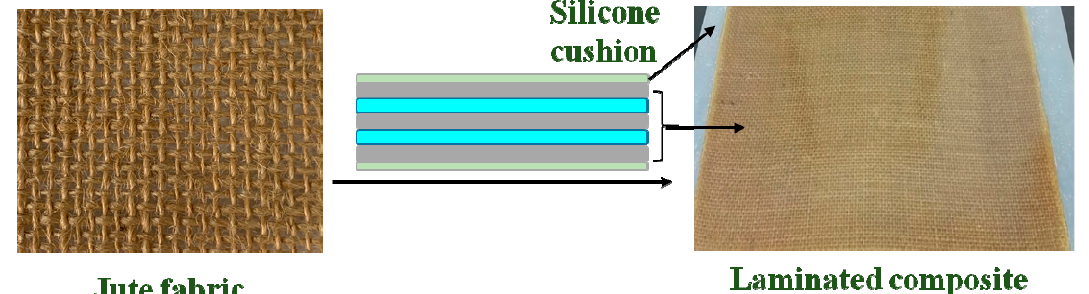
Figure 2. The KH-560-modified jute fabrics reinforced laminated composites.